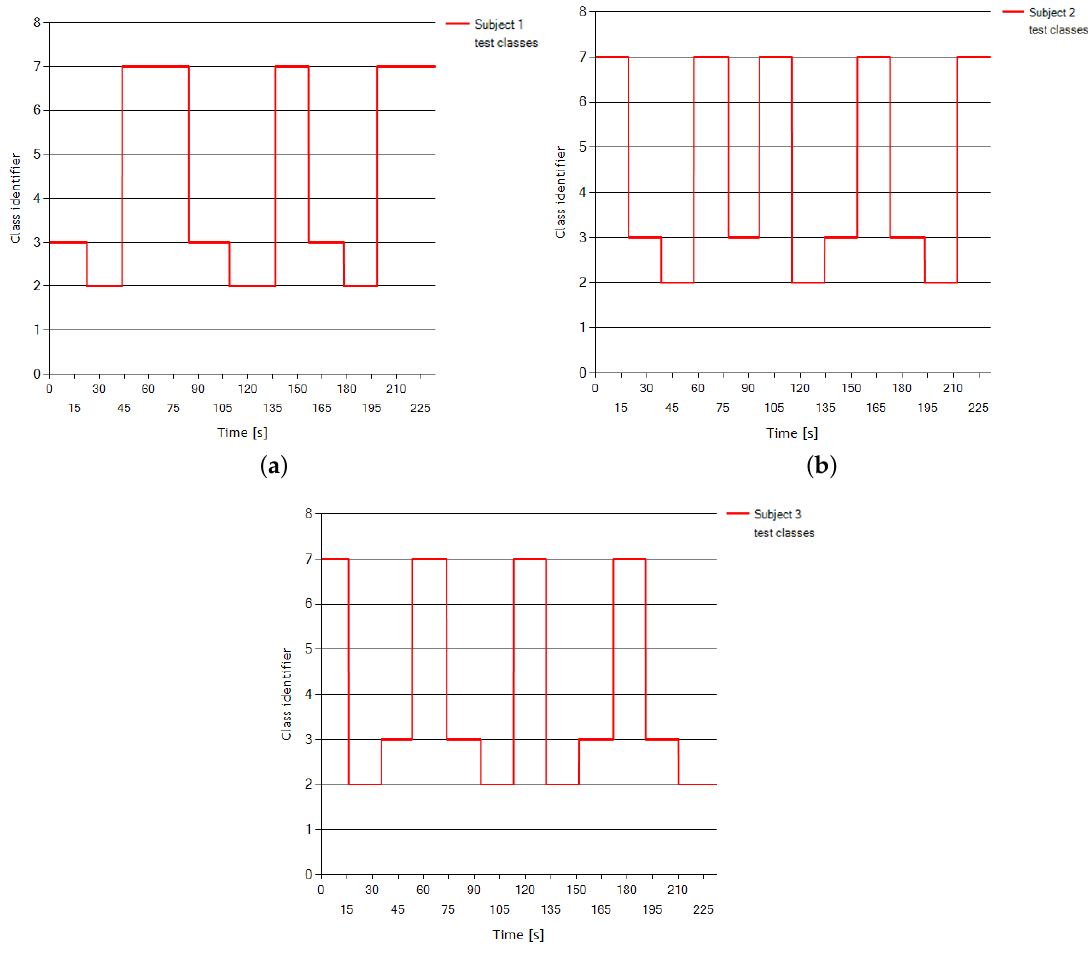
Figure 1. ( Top ) Mental tasks classes for Subject 1 ( a ) and Subject 2 ( b ) test sessions; and ( c ) mental tasks classes for Subject 3 test